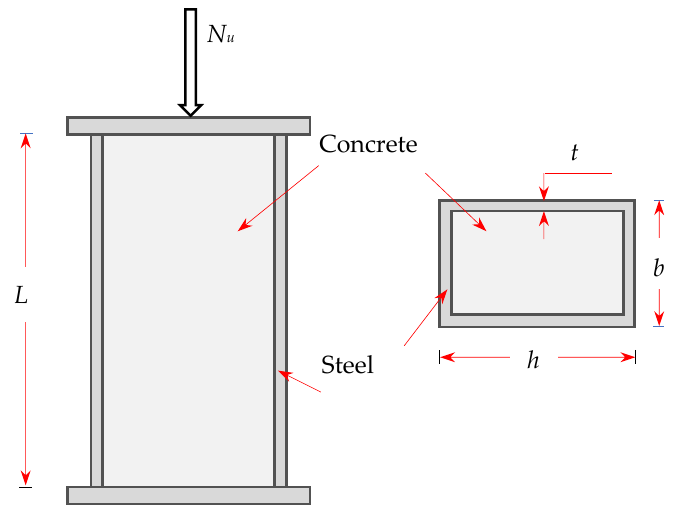
Figure 1. Test Figure 1. Test specimens.